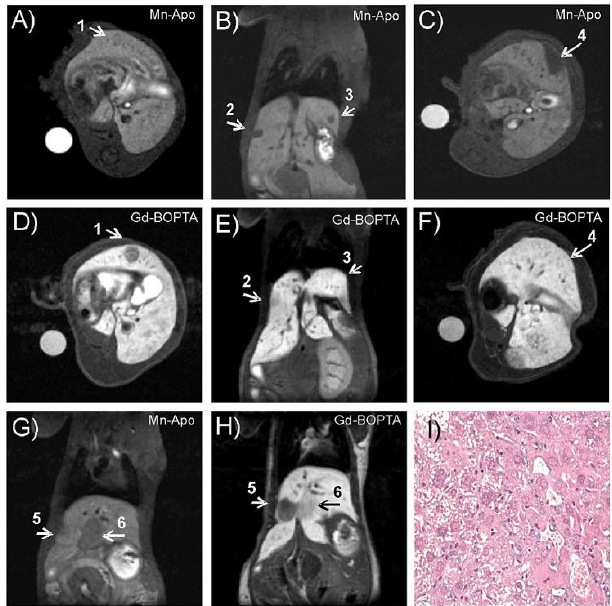
Figure 7. In vivo MRI on HBV-Tg mice. T 1 -weighted MR images (liver region), recorded at 7T, of HBV-Tg transgenic mice 20 min after the injection of Mn-Apo ( A – C , G ) and, after 72 h of Gd-BOPTA ( D – F , H ), respectively. Neoplastic lesions were indicated by growing numbers. Lesions 1 and 5 were hypointense with respect to normal liver only after Gd-BOPTA administration, but lesions 3 and 4 only after Mn-Apo injection. Lesions 2 and 6 were hypointense with both CAs. ( I ) Hepatocelular carcinoma in a 13-month-old HBV-Tg transgenic mouse ( × 200 hematoxylin–eosin). Reproduced with permission from [40] .